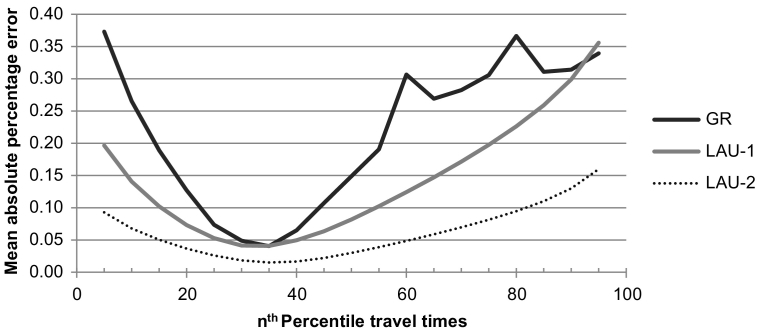
Mean absolute percentage errors for 5th to 95th percentile travel times meant to represent interaction-weighted travel times between two zones.